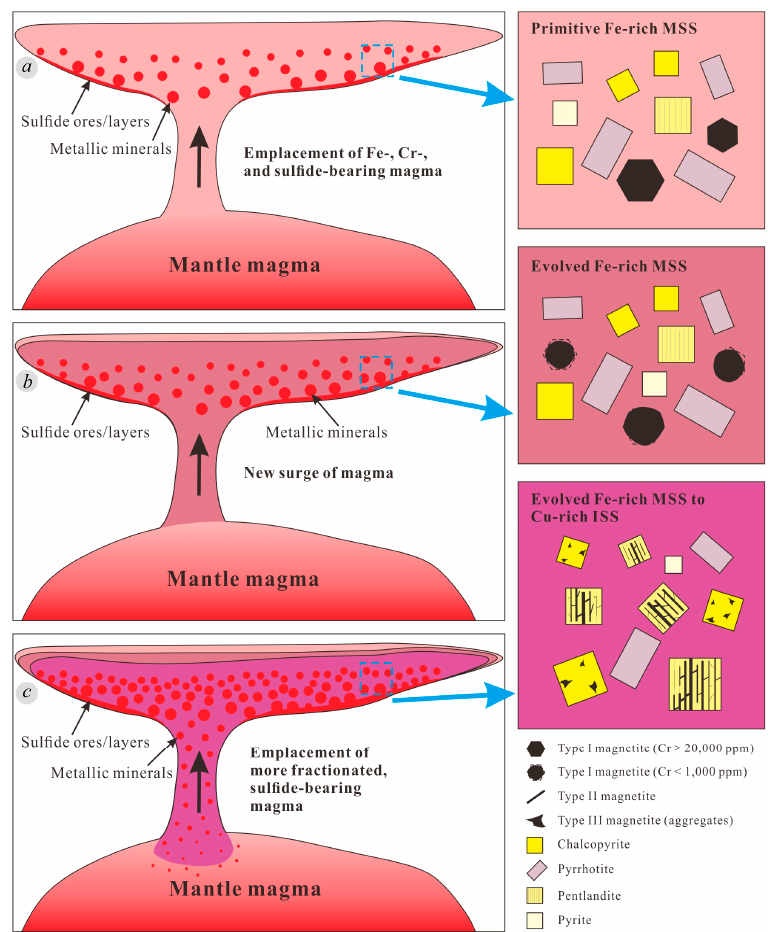
Figure 9. Schematic diagrams illustration ore-forming processes of the Jinchuan Ni-Cu-PGE